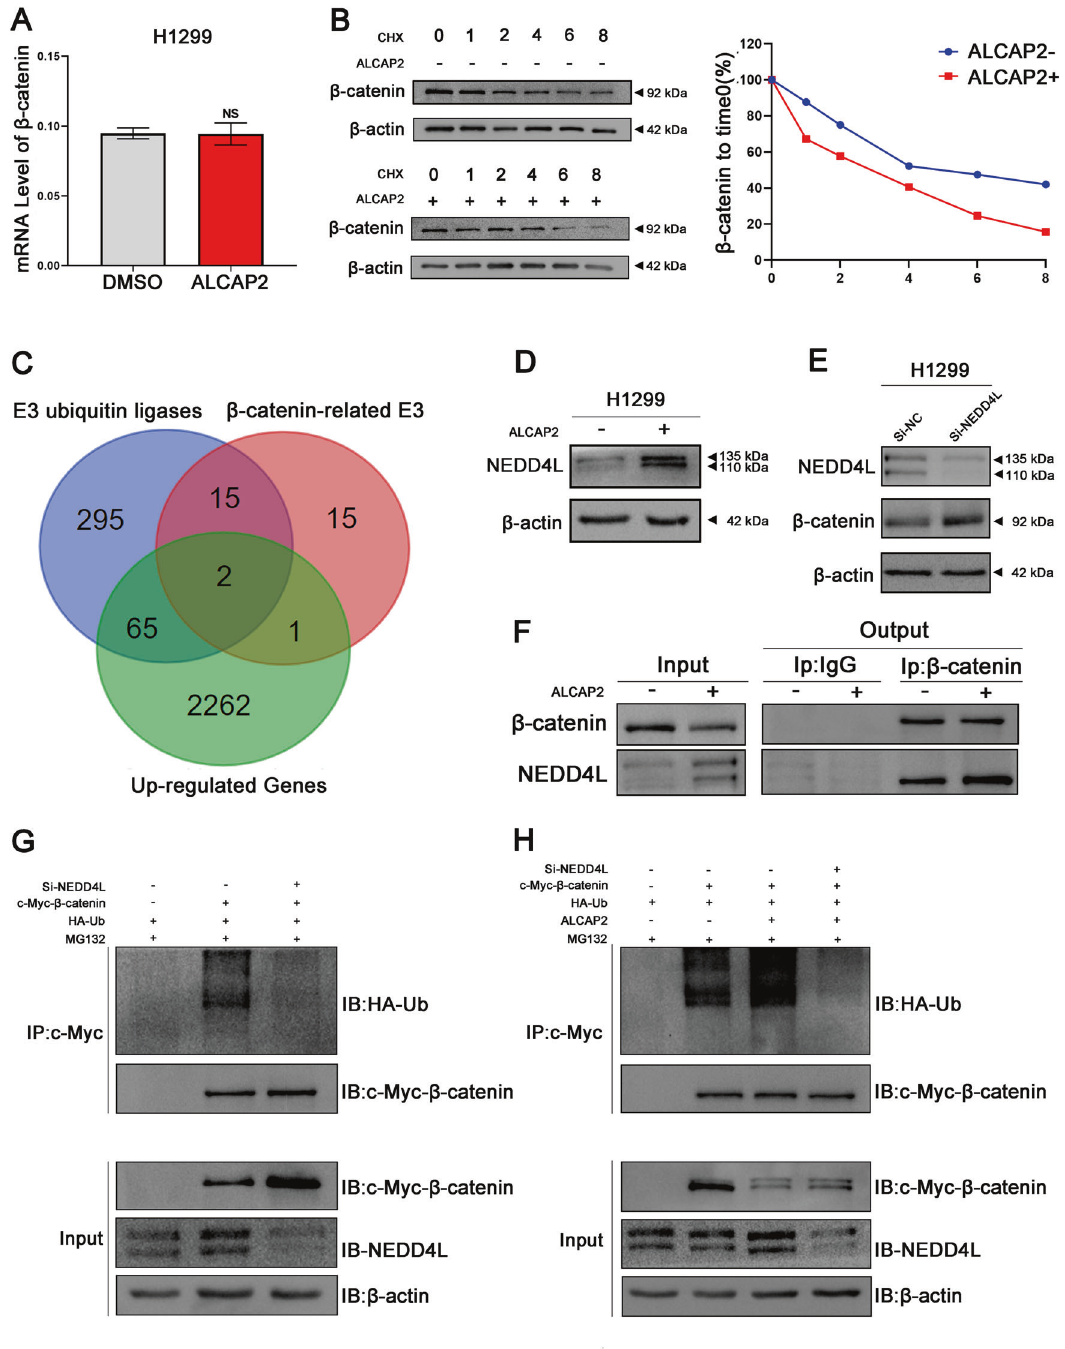
Fig. 5 ALCAP2 promotes β -catenin ubiquitination by increasing the expression of NEDD4L. A The mRNA level of β -catenin was not signi fi cantly different after treatment with ALCAP2. B The degradation of β -catenin mediated by CHX. H1299 cells treated with or without ALCAP2 were seeded into six-well plates. After 24 h, the cells were treated with 100 µg/ml CHX. Cell lysates were prepared for western blot analysis. C Three databases include upregulated genes in the RNA-Seq results [absolute fold change (FC absolute) >0.1 and p < 0.05], de fi nitive human E3 ligases and E3 ligases related to β -catenin via UbiBrowser, were used to predict the E3 ligases of β -catenin. D Protein levels of NEDD4L were increased after H1299 cells were treated with ALCAP2. E NEDD4L downregulation increased β -catenin protein expression. F The co-immunoprecipitation assay proved the association between β -catenin and NEDD4L. G The co-immunoprecipitation assay proved that NEDD4L can promote the binding of β -catenin and Ub. H Co-immunoprecipitation of β -catenin and Ub showed that ALCAP2 promoted the binding of β -catenin and Ub, and this effect was reversed in si-NEDD4L-expressing (Fig. 5C and Fig S1B, C). We veri fi ed the results in H1299 cells, fi nding that treatment with ALCAP2 increased the expression of NEDD4L at both the mRNA and protein level (Fig. S1D, E and Fig. 5D). Of these two candidates, we choose NEDD4L as the E3 ligase